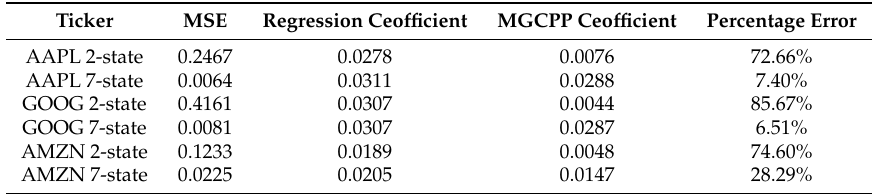
Table 7. The MSE and coefficients computed by MGCPP with 2-state and 7-state Markov chain for different tickers. The regression coefficients were derived by fitting the real standard deviations with square root curve. The MGCPP coefficients were computed by Equation (23). Ticker